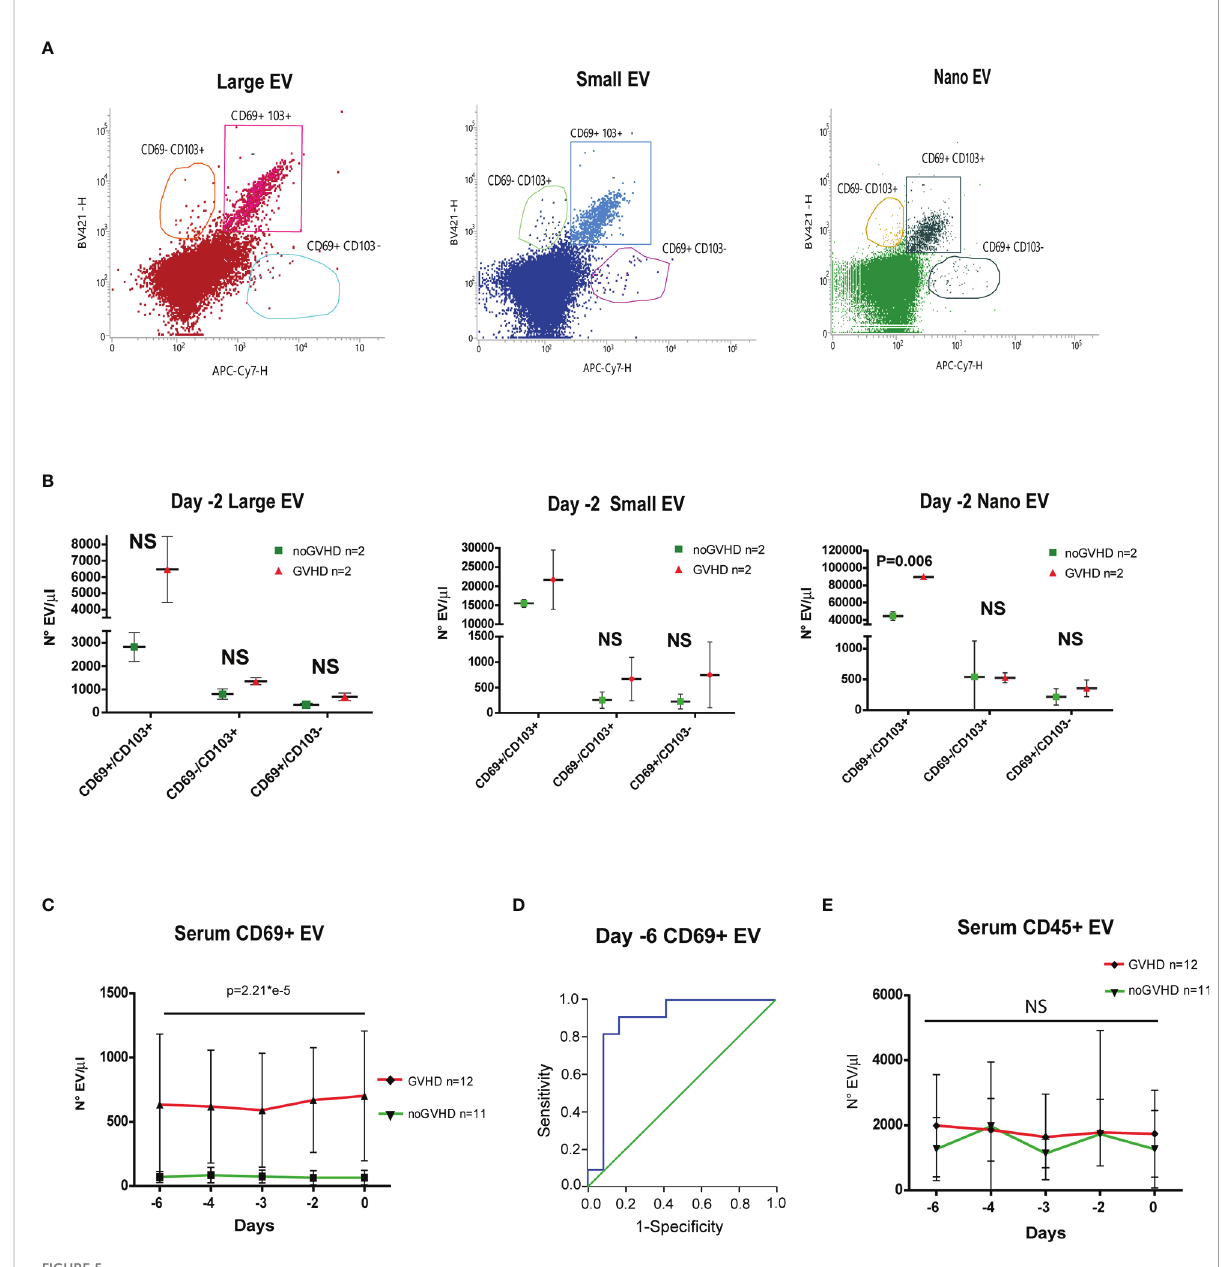
FIGURE 5 Evaluation of CD69+ EVs in HSCT samples. (A) Representative FACS analysis of serum EV size distribution and CD69/CD103 expression, in GVHD and noGVHD patients at -2 day. (B) , Dot Plot of serum CD69+/CD103-, CD69+/CD103+, CD69-/CD103+ EVs according to size distribution in GVHD (n = 2) and noGVHD (n = 2) patients at day-2. (C) FACS analysis of day -6 to day 0 serum CD69+ EVs in GVHD (n = 12) and noGVHD (n = 11) patients. (D) , ROC analysis of serum CD69+ EVs in GVHD and noGVHD patients. (E) FACS analysis of day -6 to day 0 serum CD45+ EVs in GVHD (n = 12) and noGVHD (n = 11) patients. Values are expressed as number of EVs/ m l. Data are reported as mean +/- S.D.; p refers to GLM analysis for repeated measures. NS, Not Signi fi